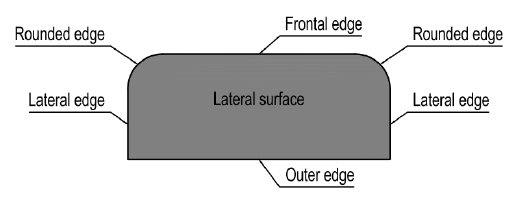
Fig. 4 Definitions of the part of the